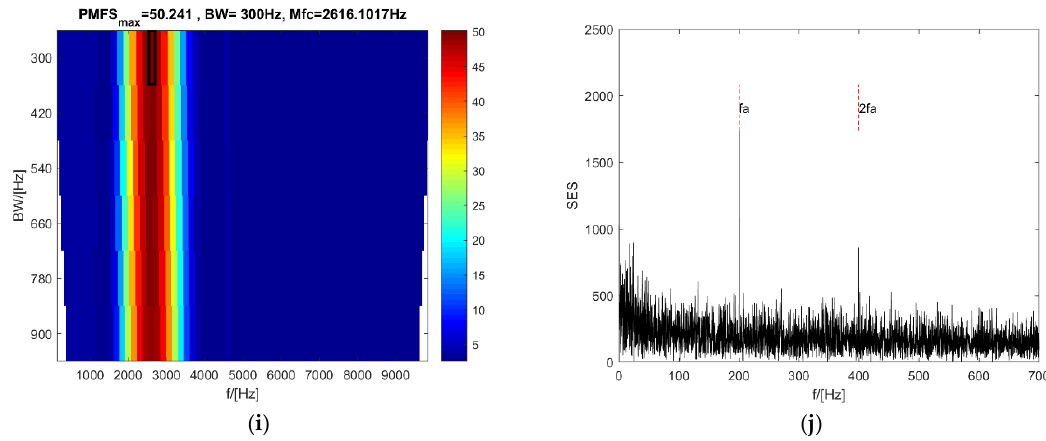
Figure 6. Analysis results of 4.3: ( a , b ) the synthesized signals before WGN noise is added and after WGN noise is added; ( c , d ) the protugram and the SES of its optimal frequency band; ( e , f ) the PMgram and the SES of its optimal frequency band; ( g , h ) the enhanced kurtogram and the power spectrum of its optimal frequency band; ( i , j ) the PMFSgram and the SES of its optimal frequency band.